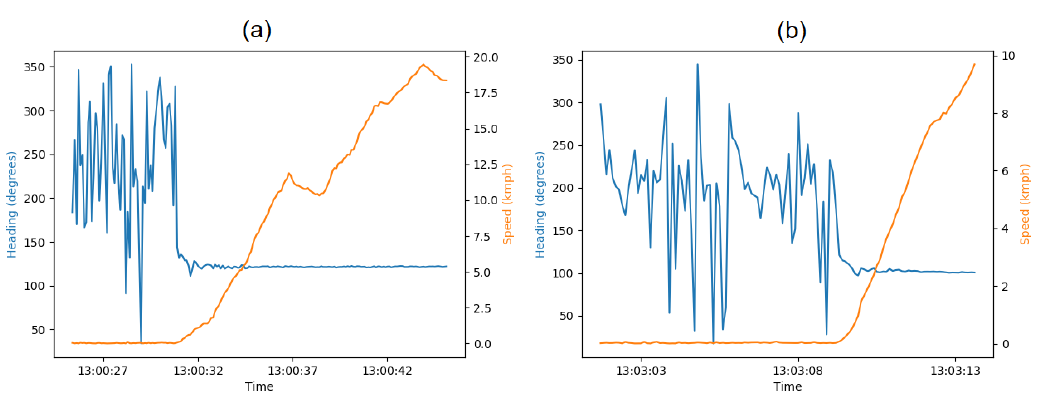
Figure A3. Speed and Heading values with respect to time in two different sections ( a ) and ( b ) of the track.